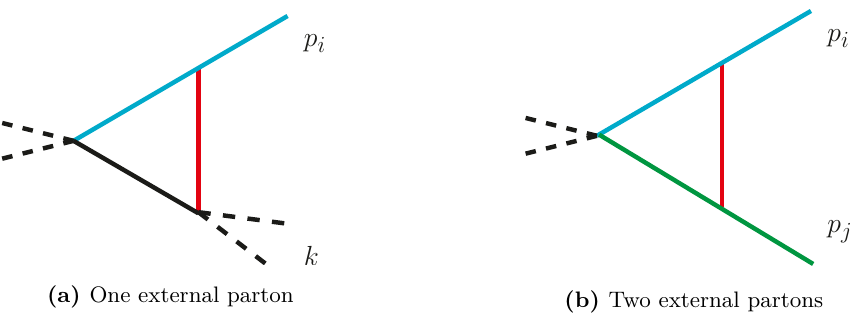
Figure 1. Divergent scalar triangle functions. Momentum flows from left to right. The red colour indicates a massless propagator while the blue and the green colour going from an internal to an external line means that the mass of the propagator is the same of the external (on-shell) particle with the same